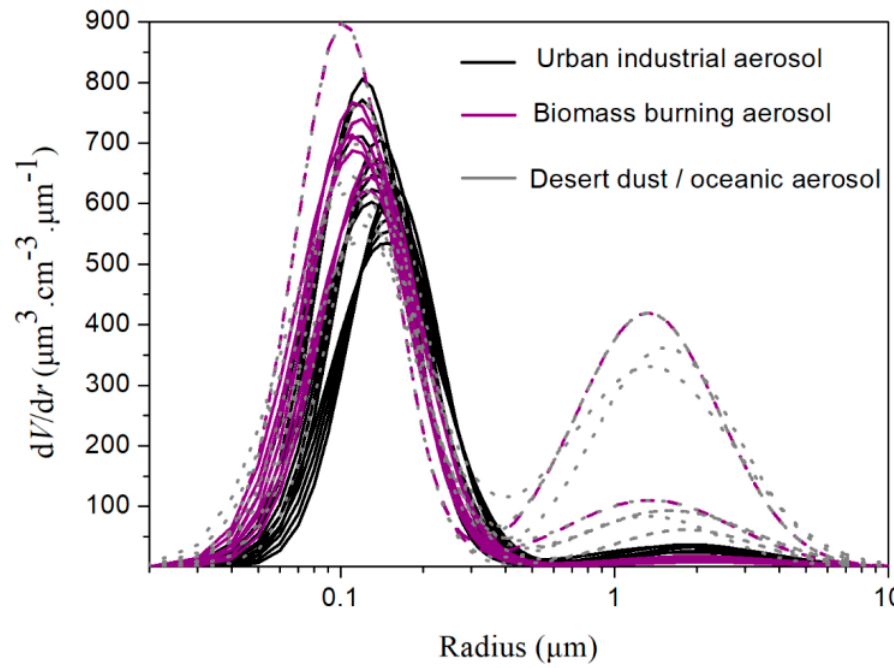
Figure 3. Particle volume size distribution involved in the simulation.